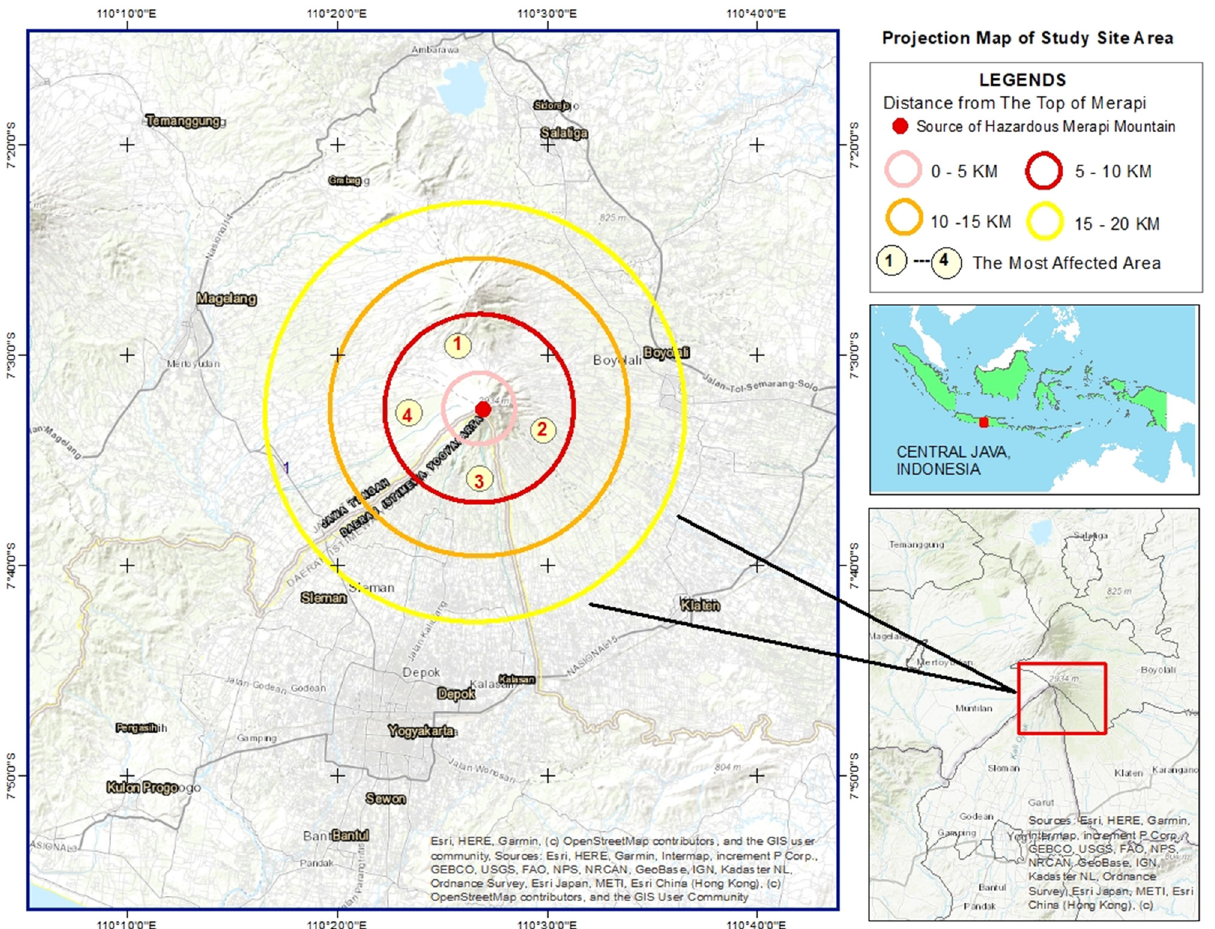
Figure 1: Study area located in the Central Java Province and the Special Region of Yogyakarta, Indonesia: ( 1 ) Tlogolele Village, ( 2 ) Jemowo Village, ( 3 ) Glagaharjo Village, and ( 4 ) Krinjing Village; adopted from [ 16 ]